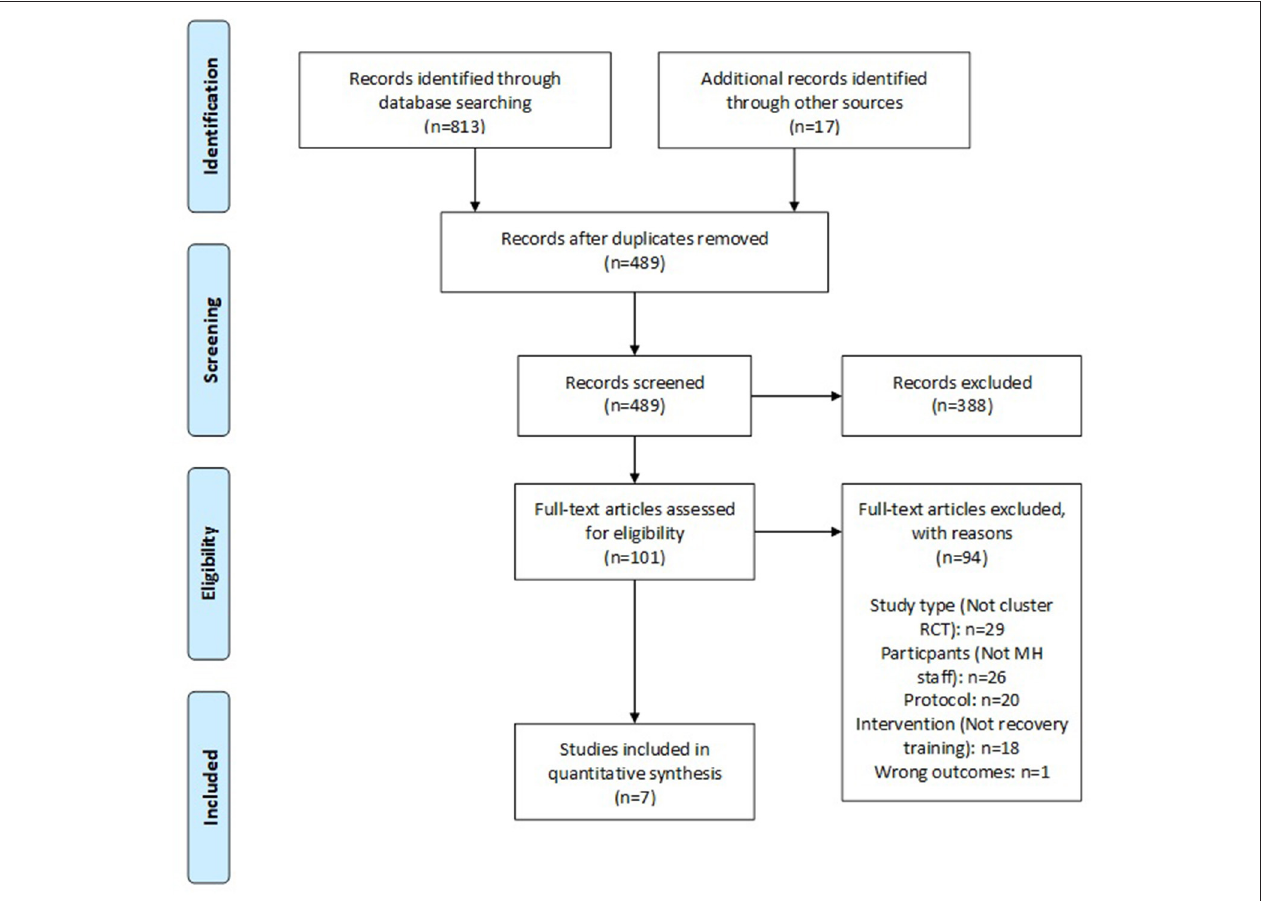
FIGURE 1 | PRISMA